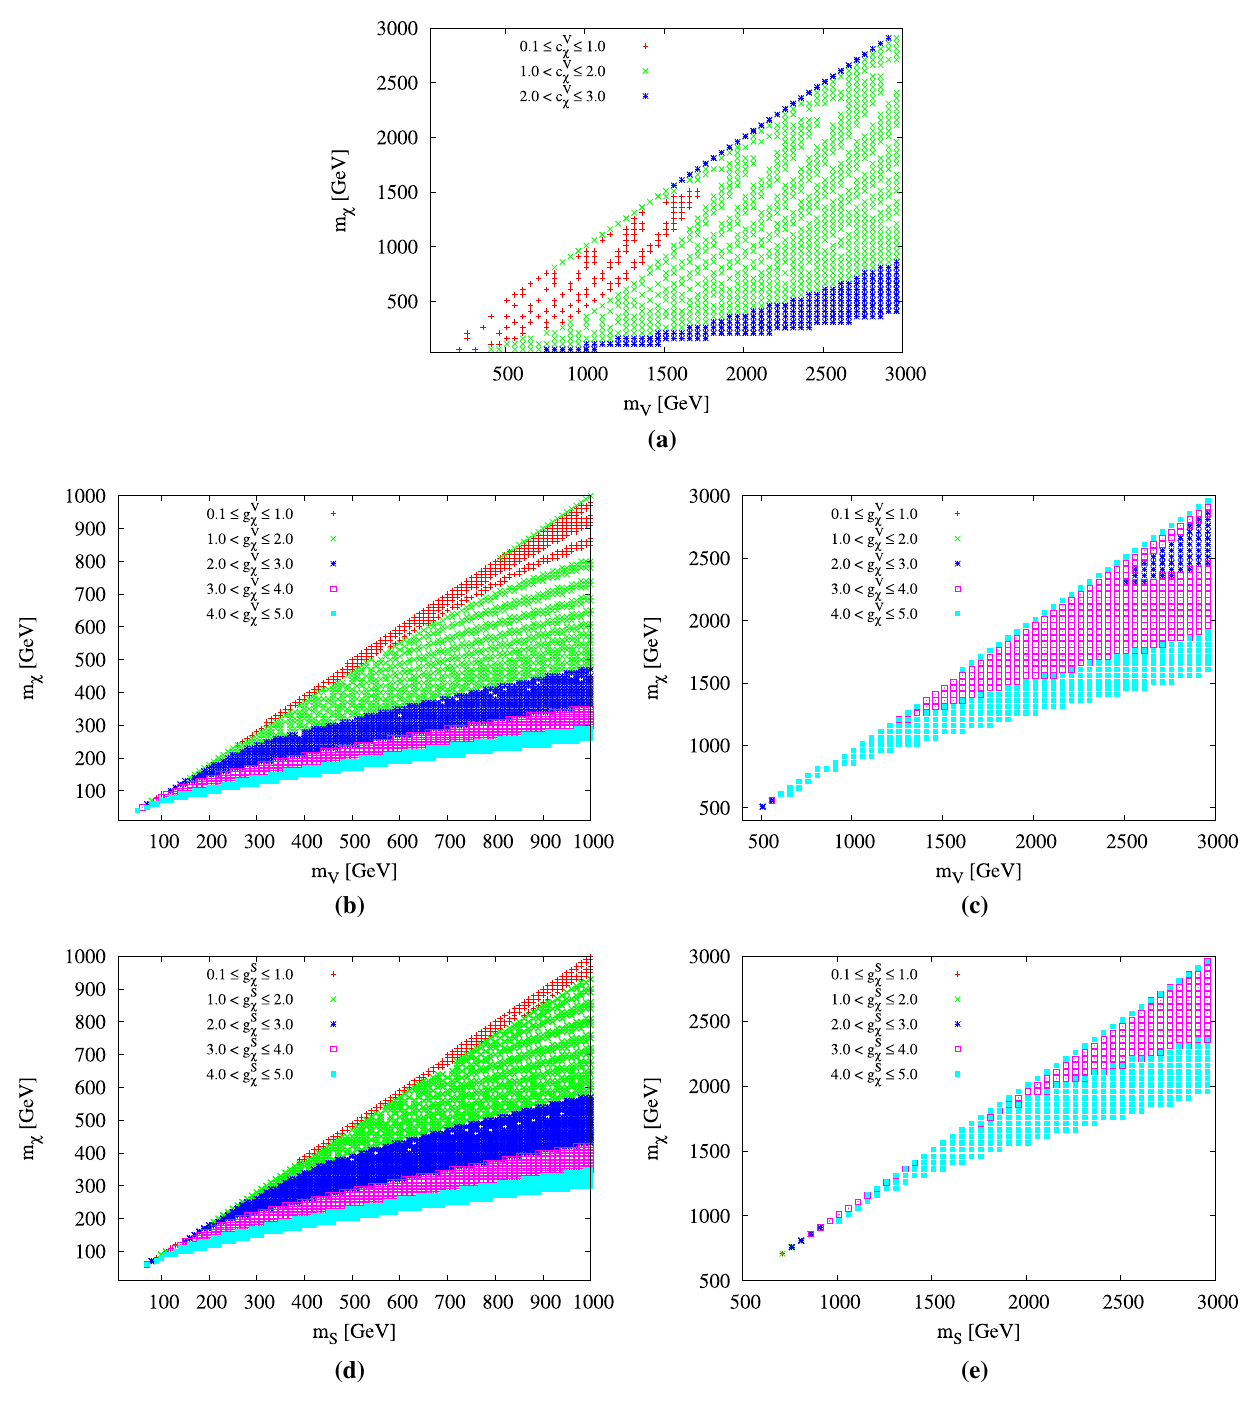
Fig. 1 Contour plots in the allowed DM mass m χ and the mediator mass m V / m S . The color gradient corresponds to different values of the coupling. We have assumed that the DM χ saturates the observed relic density. The top panel corresponds to the dimension-4 interaction term for the vector mediator case. The middle and the bottom panels the cut-off scale and we find that co-annihilation is important for DM particle masses up to roughly 1.5 TeV. The middle and the bottom panels are for dimension-5 vector and scalar